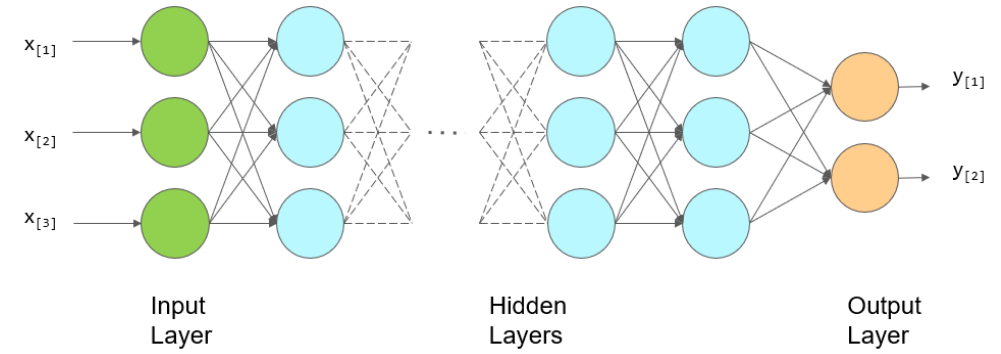
Figure 1. A structural diagram of a feedforward neural network (FNN), which consists of an input layer, one or more hidden layers, and an output layer, each containing one or more artificial